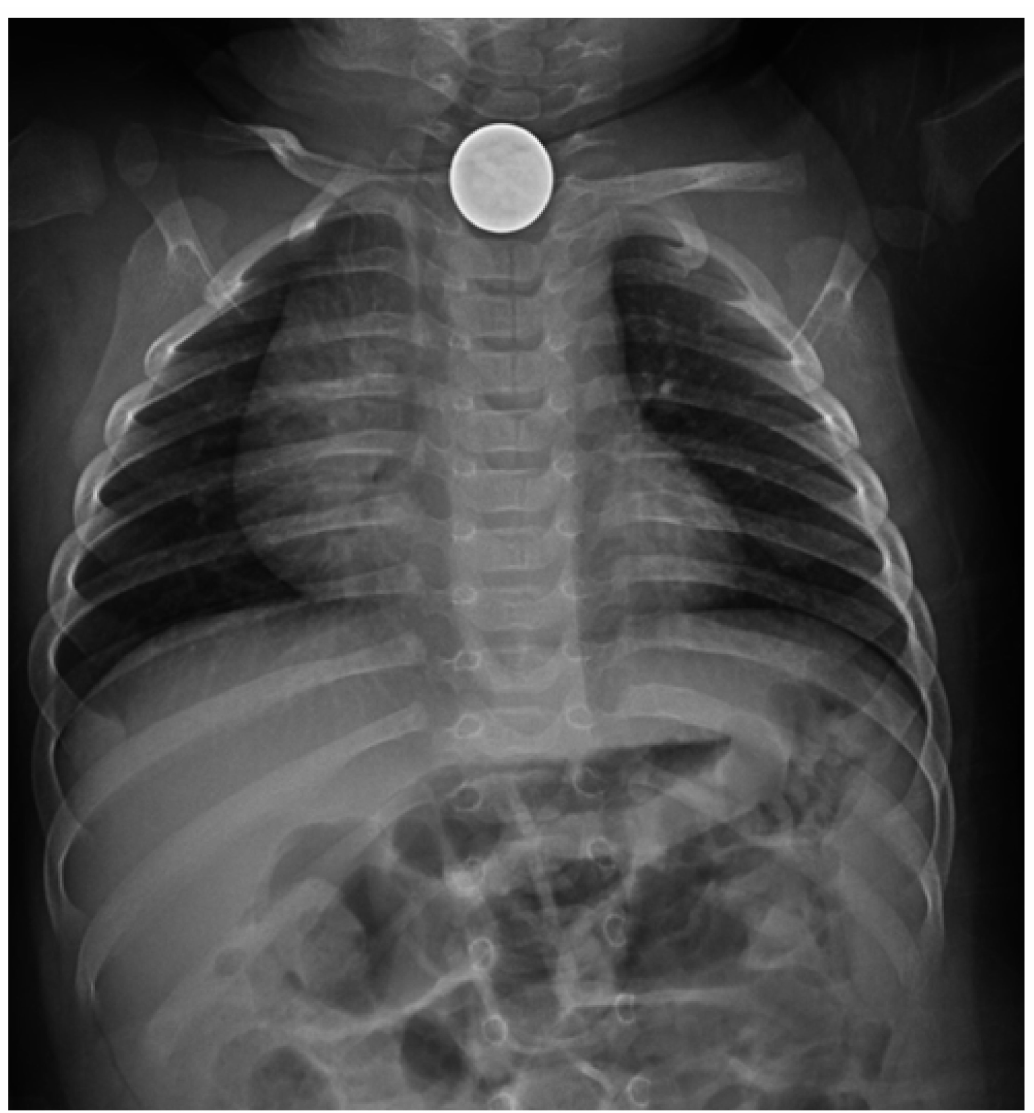
Figure 1. Chest radiograph showing a coin lodged in upper esophagus. Details suggesting it is a United States dime are visible on close inspection (photo courtesy of Timothy Johnson, DO,